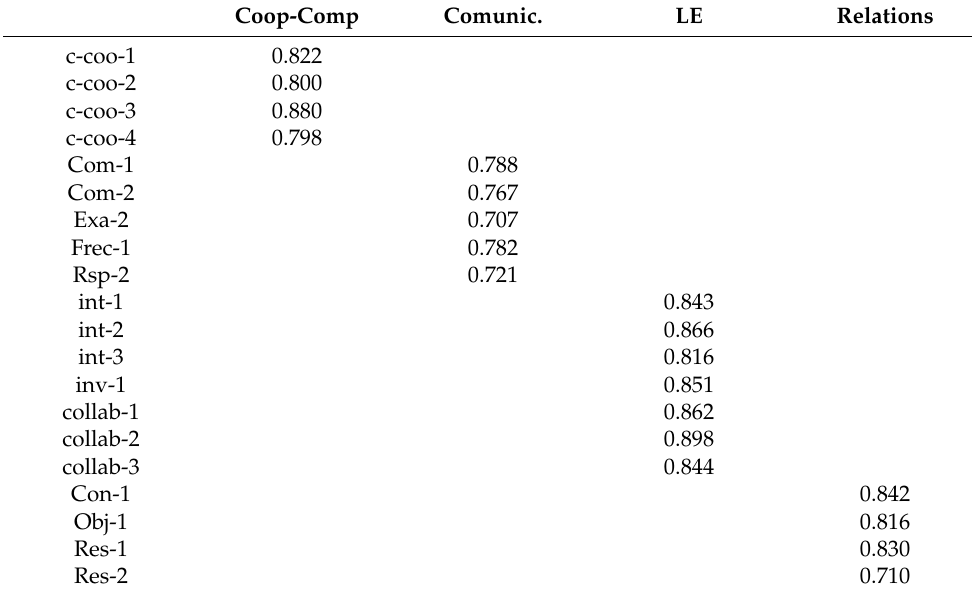
Table 1. Outer model loadings.